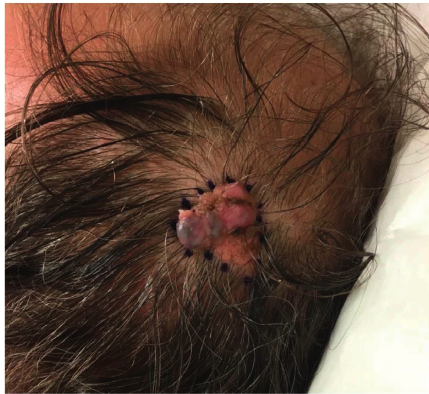
Figure 1: Clinical appearance of left parietal lesion at presentation to dermatology clinic.